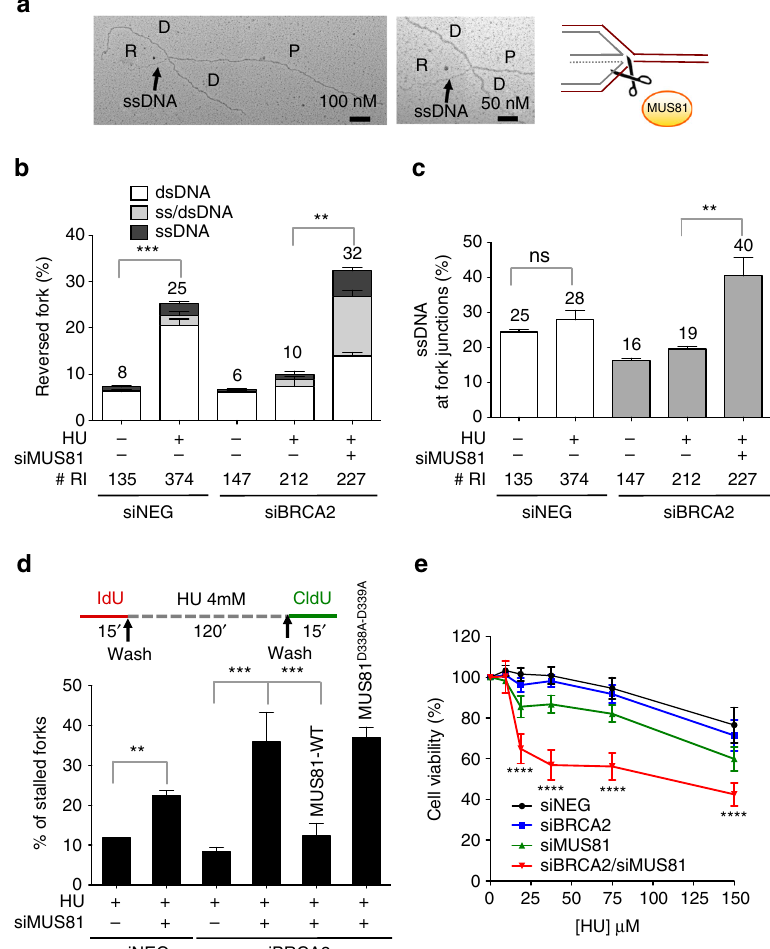
Fig. 5 MUS81 cleaves partially resected regressed forks with a ssDNA tail to promote fork rescue in BRCA2-de fi cient cells. D daughter strand, P parental strand, R reversed arm. a Left, representative electron micrograph of a reversed fork with a single-stranded regressed arm. Center, magni fi ed four-way junction at the reversed replication fork with a single-stranded regressed arm. The black arrow points to the ssDNA region on the regressed arm. Right, schematic model of the substrate cleaved by MUS81. b Frequency of fork reversal and ssDNA composition of the reversed arms in BRCA2 -de fi cient U2OS cells treated with 4 mM HU for 5 h. Cells were transfected with control siRNA (siNEG) or MUS81 siRNA. The percentage values are indicated on the top of the bar. “ # RI ” indicates the number of analyzed replication intermediates. Mean shown, n = 3. Errors, S.E.M. Statistics: unpaired t test; ** P < 0.01; *** P < 0.001. c Percentage of forks with ssDNA at the fork junction in BRCA2-de fi cient U2OS cells treated with 4 mM HU for 5 h. Cells were transfected with control siRNA (siNEG) or MUS81 siRNA. The percentage values are indicated on the top of the bar. “ # RI ” indicates the number of analyzed replication intermediates. Mean shown, n = 3. Errors, S.E.M. Statistics: unpaired t test; ** P < 0.01. d Quanti fi cation of restarting forks in BRCA2-de fi cient and -pro fi cient U2OS cells with or without MUS81 siRNA knockdown. MUS81-depleted cells were complemented with wild-type (MUS81-WT) or catalytically dead (MUS81 D338A-D339A ) MUS81, when indicated. Out of 3 repeats, the percentage is established on at least 250 tracts scored for each data set. Mean shown. Errors, S.E.M. Statistics: unpaired t test; ** P < 0.01; *** P < 0.001 e Cell viability assays 72 h upon treatment with the indicated doses of HU. U2OS cells were transfected with control siRNA (siNEG), BRCA2 siRNA, or MUS81 siRNA. Mean shown, n = 6. Errors, S.E.M. Statistics: two-way ANOVA, *** P > 0.001; **** P > 0.0001 (differences between BRCA2 siRNA and BRCA2/MUS81 siRNA) responsible to rescue partially resected regressed forks in BRCA2- the in vitro data showing that MUS81 ef fi ciently cleaves 3 ′ fl aps, de fi cient cells. We speculate that the MUS81/POLD3-dependent Y-shaped structures and nicked Holliday junctions (HJ), but has pathway used to rescue resected forks in BRCA2-de fi cient cells might represent a novel anticancer drug target speci fi c for reversed fork substrate) 30, 39, 40 . In the absence of MUS81 clea- BRCA2-defective tumors to be used in combination with che- motherapeutics that cause replication fork reversal and degradation.